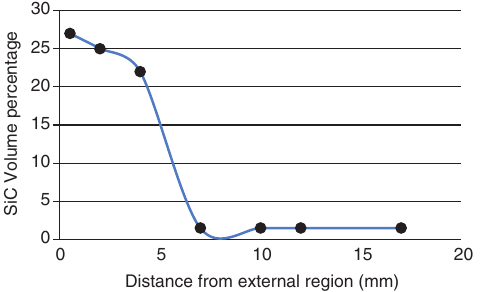
Figure 6 Graded distribution of SiC particles from the external to the internal region in the FG